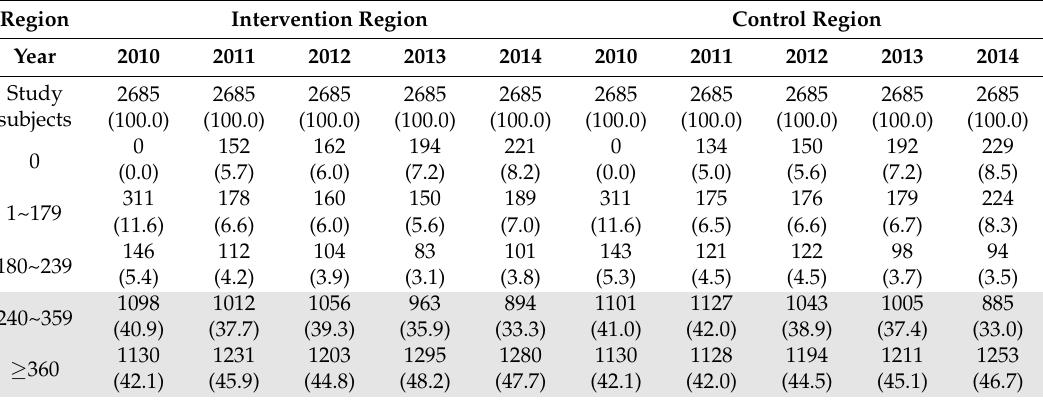
Table 3. Comparison of insurance benefit days * for treating hypertension between study regions.